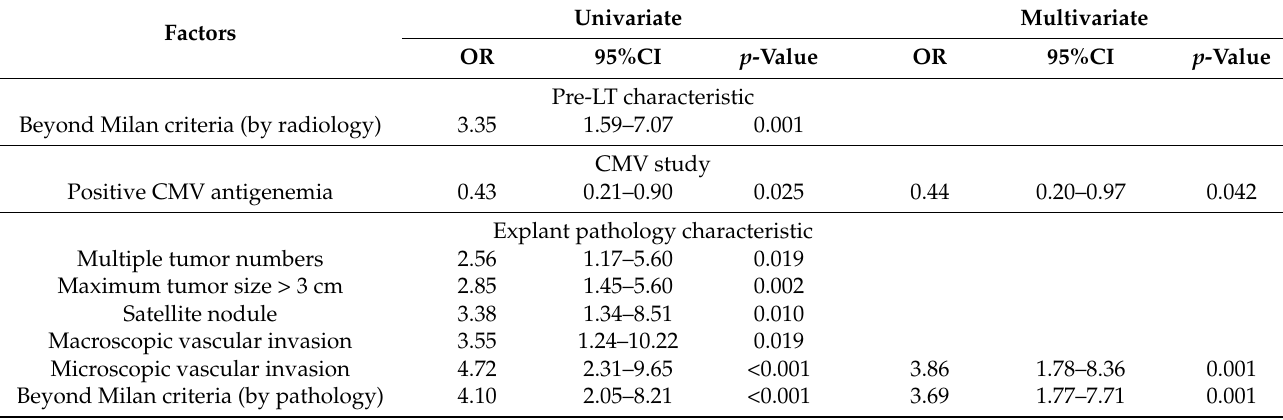
Figure 2. Kaplan–Meier method for five-year cumulative overall survival (OS) depending on positive and negative CMV antigenemia results. The five-year cumulative OS between the CMV antigenemia-positive and CMV antigenemia-negative groups were not significantly different. Table 3. Uni-/multivariate analyses in predicting HCC recurrence after liver